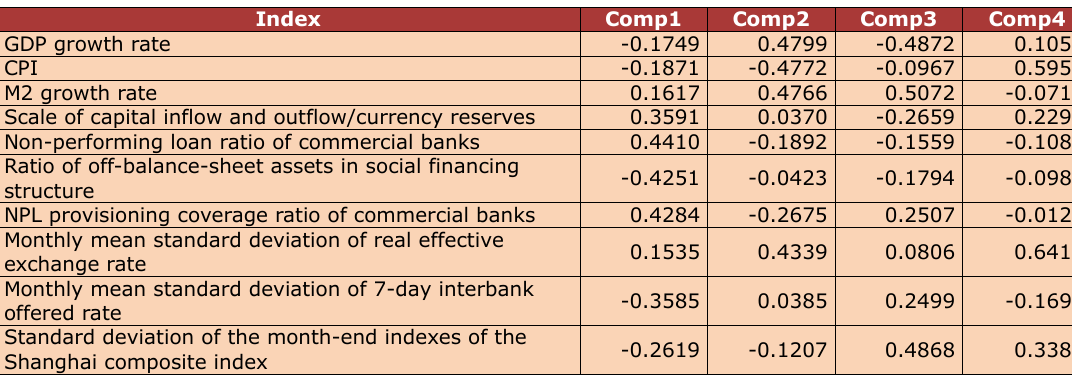
Table 4. First Four Principal Component eigenvectors